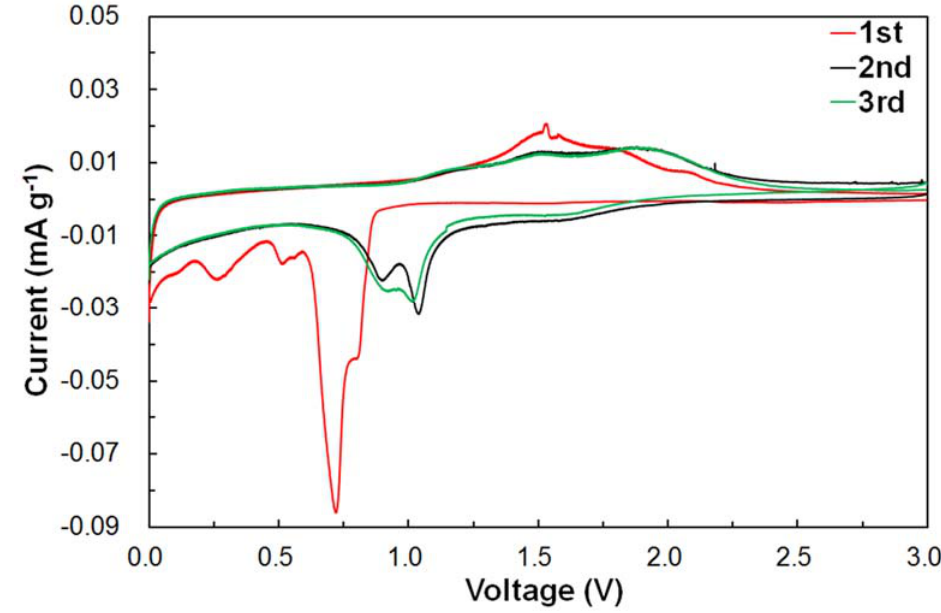
Figure 8. Cyclic voltammetry curves of the NiFe 2 O 4 electrode annealed at 800